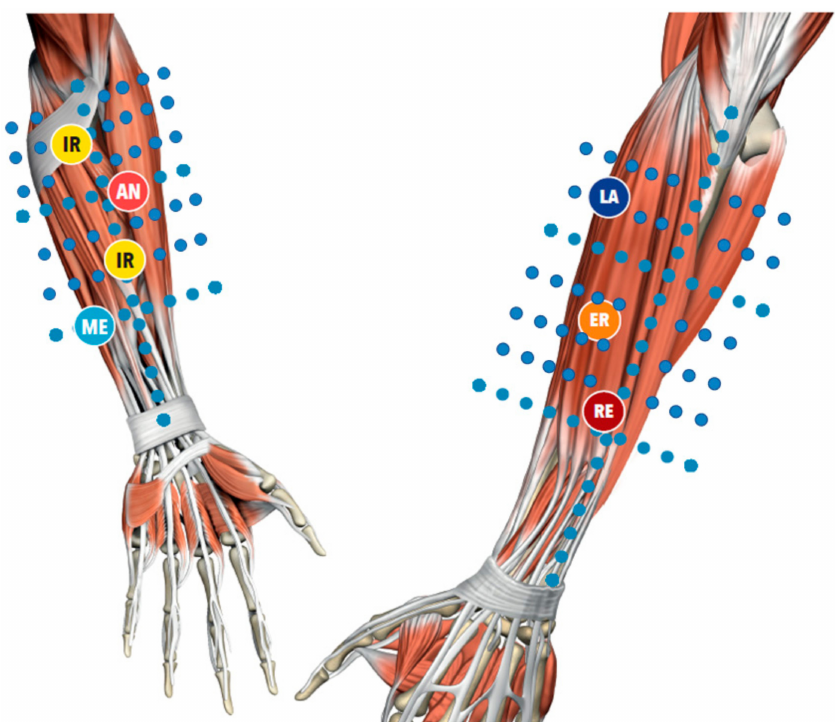
Figure 2. Location of the center of coordination. AN = antemotion; RE = retromotion; ME = mediomotion; LA = lateromotion; IR = intrarotation; ER = extrarotation. The blue dots represent the slides were coronal MRI were